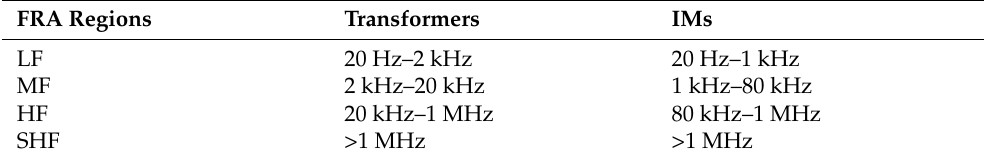
Table 6. The common FRA regions limits for power transformers and the proposed regions for IMs. FRA